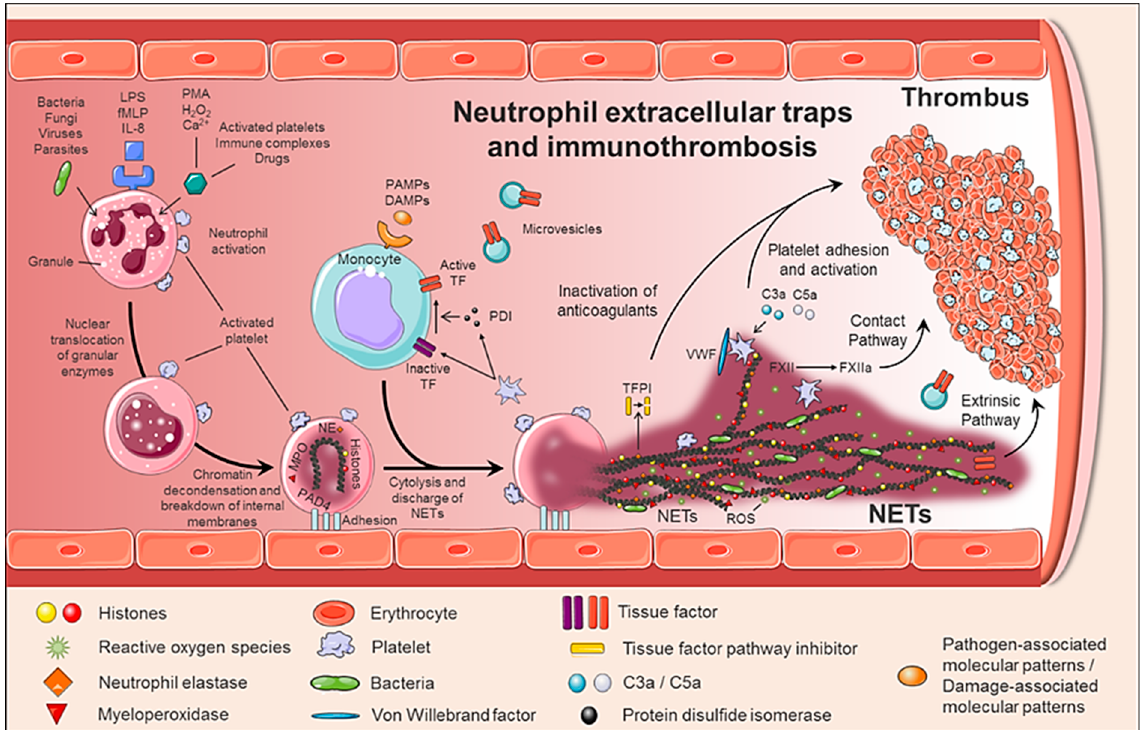
Figure 2. Generation of neutrophil extracellular traps (NETs) and immunothrombosisconcept. The formation of NETs is a dynamic and complex process, in which not only neutrophils are involved, but also other circulating cells such as monocytes and platelets. When activated, neutrophils adhere to the endothelium and granular enzymes (myeloperoxidase and elastase) are translocated to the nucleus, which together with the activation of PAD4 promotes the decongestion of chromatin, the loss of the lobular form of the neutrophil and the rupture of its nuclear membrane. Finally, granular proteins bound to chromatin are expelled into the extracellular space (NETs), providing a perfect structure not only to immobilize and to kill pathogens, but also to induce a pro-coagulant